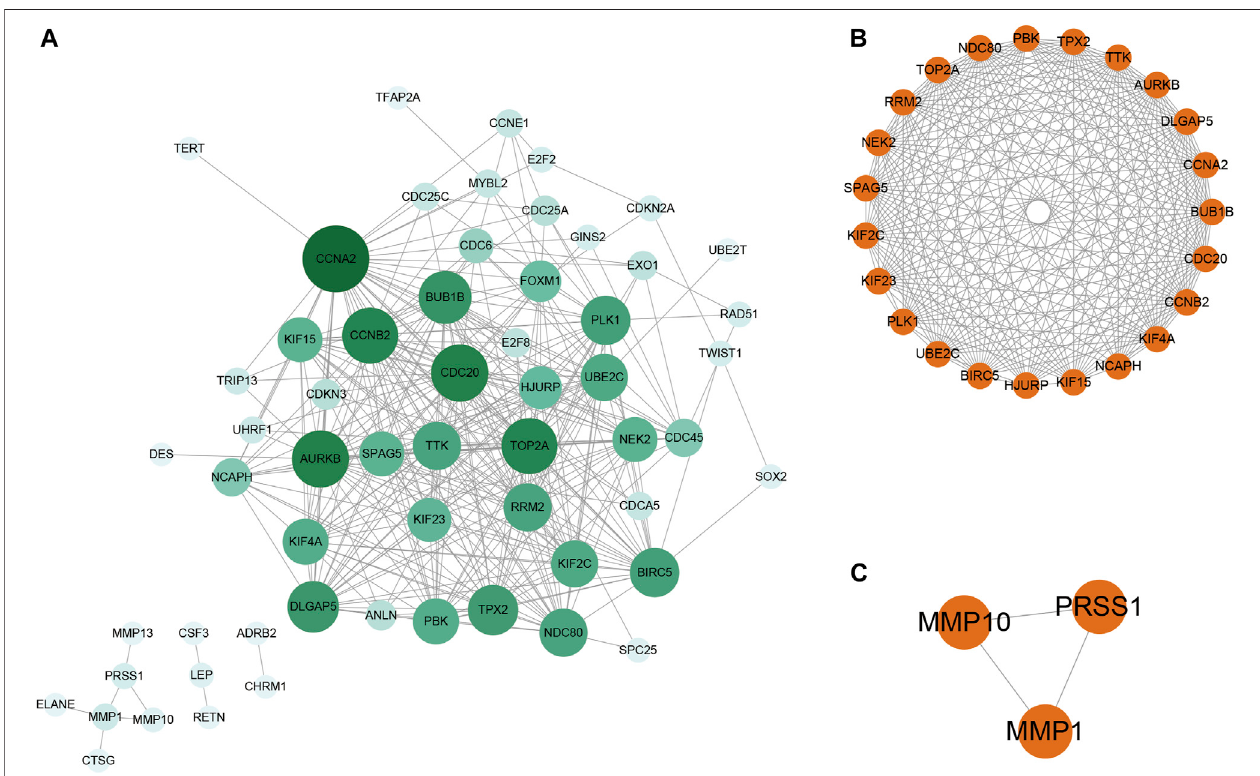
FIGURE 5 | PPI network analysis and sub-network analysis based on identi fi ed COVID-19/NSCLC interactional genes. (A) PPI network containing 59 nodes and 347 edges. (B) Biggest sub-network of the PPI network. (C) Small sub-network of the PPI network. Note: nodes represent interactional genes, and edges represent interaction relationships. The depth of the color of the node is positively correlated with the degree value in panel (A) .